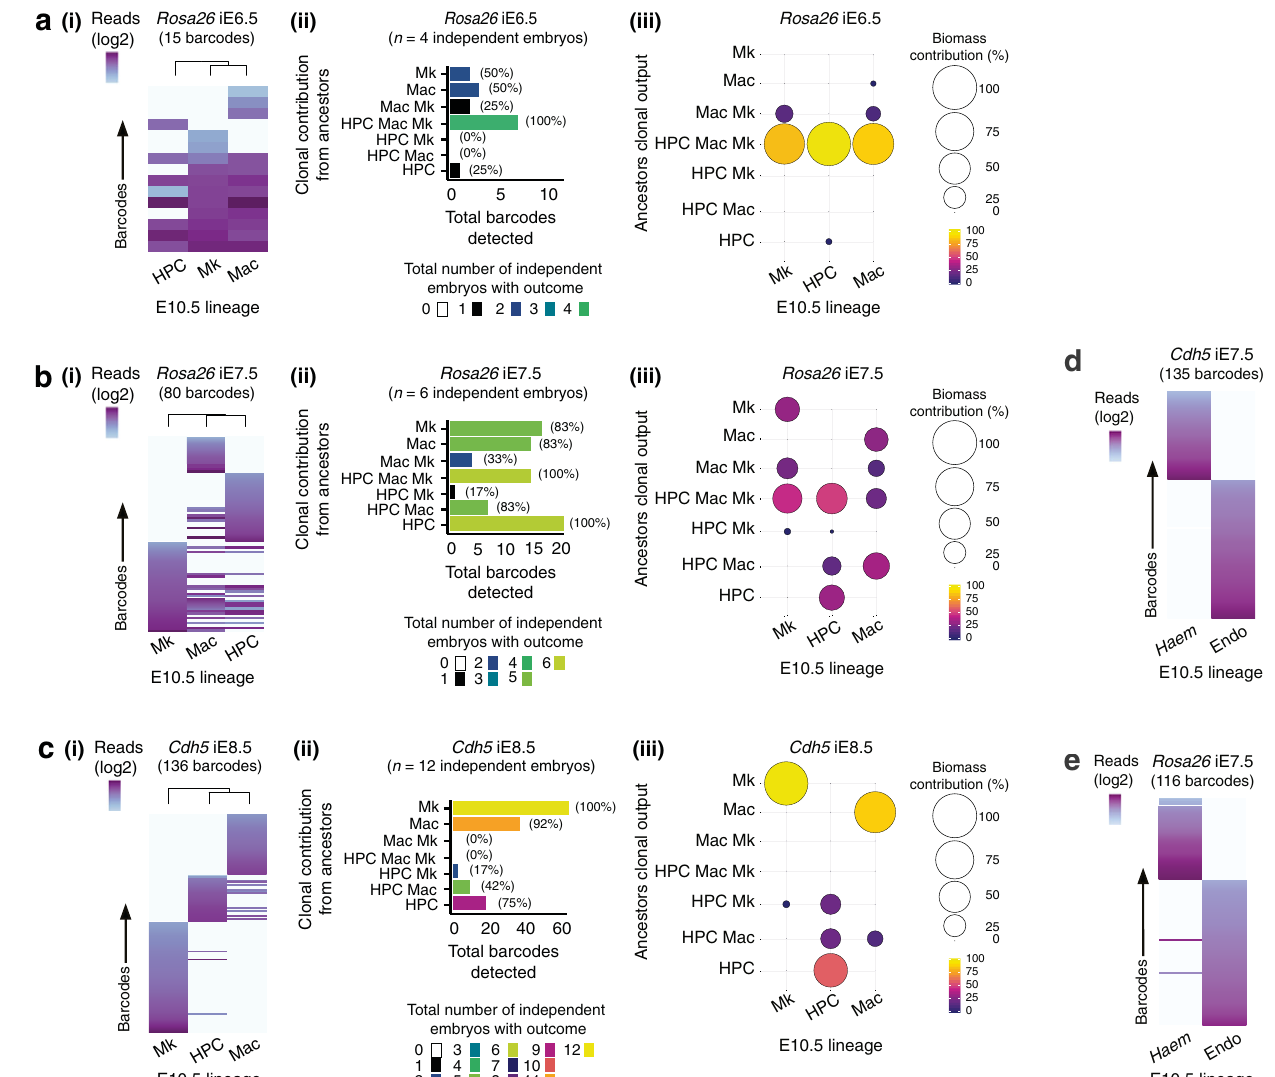
Fig. 4 | Investigating haematopoietic and endothelial lineage relationships. a Induction of barcode formation at E6.5 using Rosa26 iCre (15 barcodes, n =4 embryos).(i)Heatmapsofallinformativebarcodes.(ii)Biologicalreproducibilityof clonaloutcomes.Coloursrepresentthetotalnumberofindependentembryoswith the stated clonal outcome. Values in parentheses represent the percentage of independent embryos inwhich the clonaloutcomewas observed.(iii)Summaryof contribution to the E10.5 yolk sac non-erythroid haematopoietic lineages biomass (based on 5 – 9 element barcodes [12 barcodes]). b Induction of barcode formation at E7.5 using Rosa26 iCre (80 barcodes, n =6 embryos). (i) Heatmaps of all infor- mative barcodes. (ii) Biological reproducibility of clonal outcomes. Colours represent the total number of independent embryos with the stated clonal out- come. Values in parentheses represent the percentage of independent embryos in whichtheclonaloutcome wasobserved.(iii)Summaryof contributionto theE10.5 yolk sac non-erythroid haematopoietic lineages biomass (based on 5 – 9 element